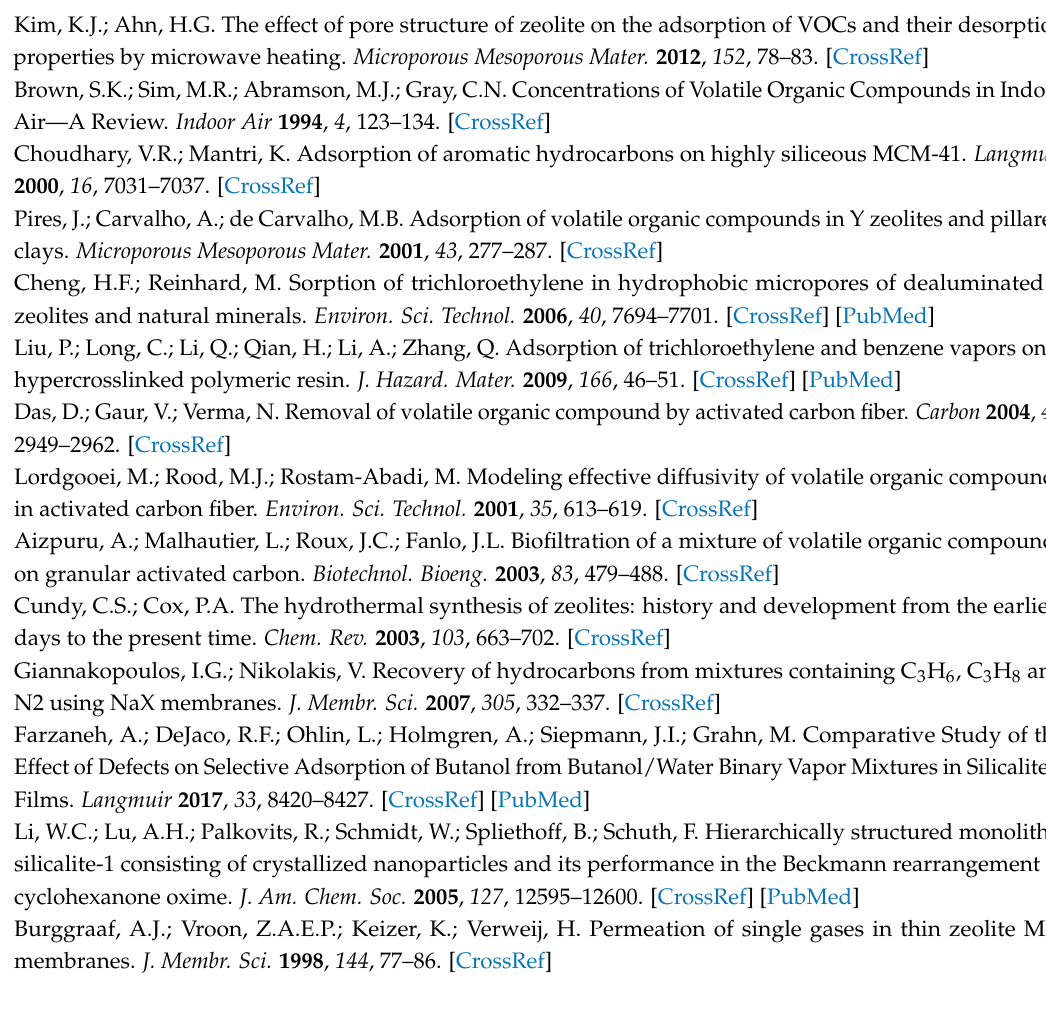
Figure S1: N2 adsorption-desorption isotherms of Dt/S-1(1 wt%), Dt/S-1(10 wt%) and Dt/S-1(20 wt%), Figure S2: X-ray diffraction (XRD) patterns of the Dt/S-1(5 wt%) synthesized at different temperature, Table S1: Porous parameters of Dt, S-1 and Dt/S-1(5